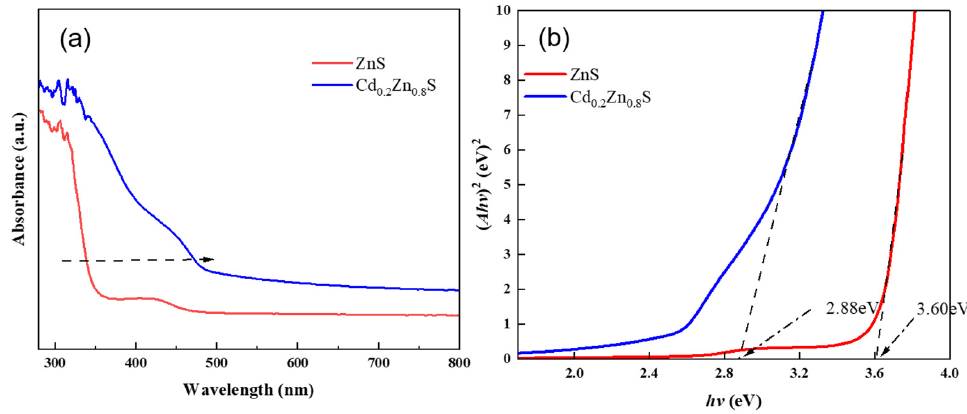
Figure 4. ( a ) UV-vis DRS of ZnS and Zn 0.8 Cd 0.2 S ( b ) Plot of transformed Kubelka-Munk function versus photon energy for ZnS and Zn 0.8 Cd 0.2 S.